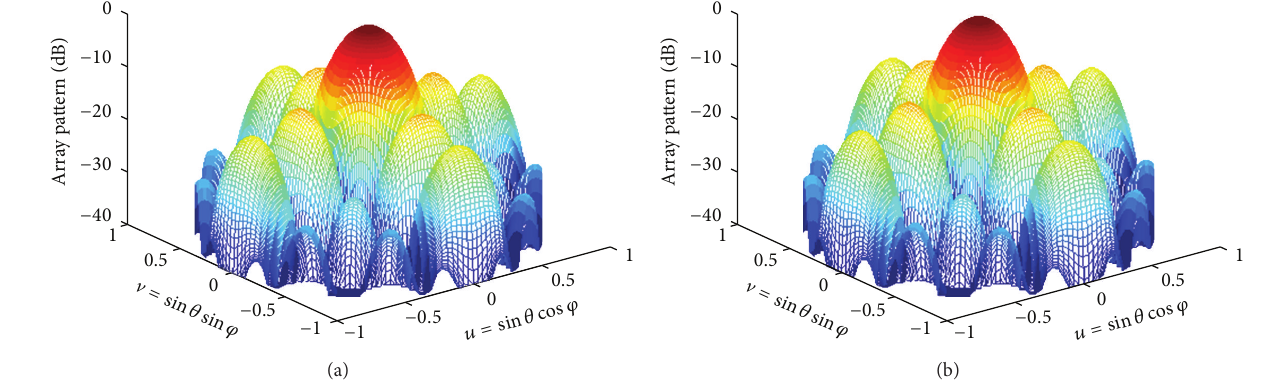
Figure 2: (a) The desired radiation pattern. (b) The reconstructed radiation pattern.